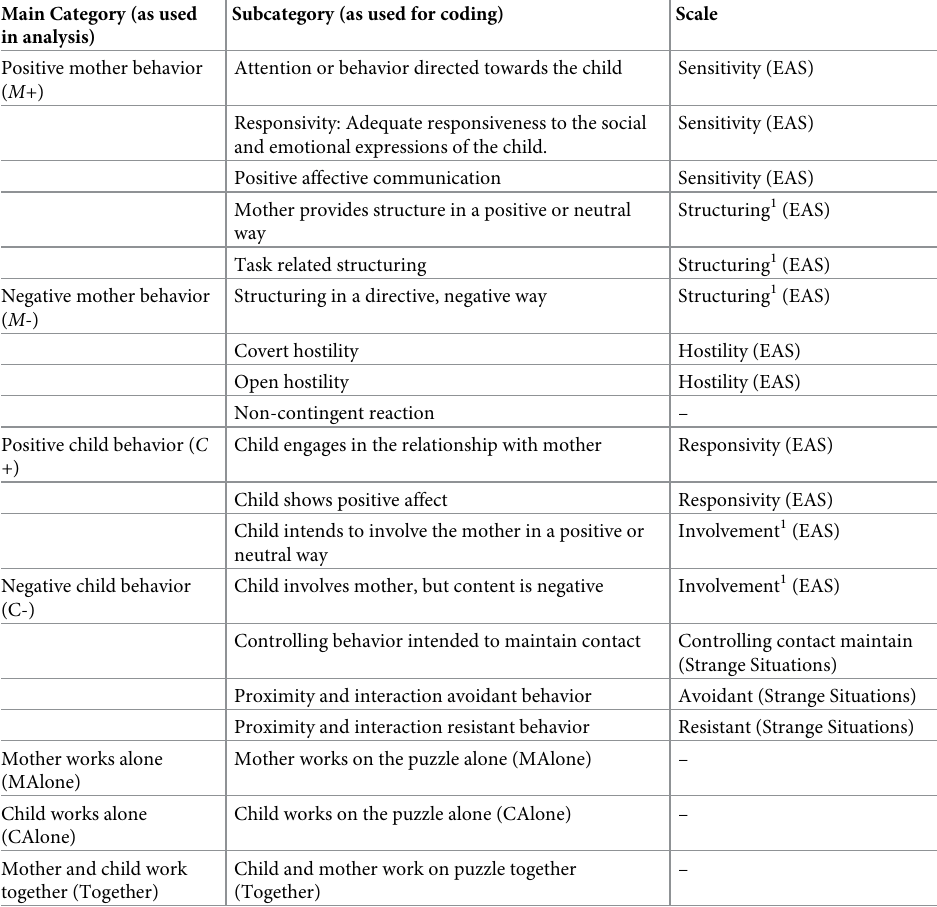
Table 1. Main categories and subcategories of the MCAM, also indicating by which subscales of the emotional availability scale (EAS) [9] or strange situations procedure [3] they are inspired. Main Category (as used in